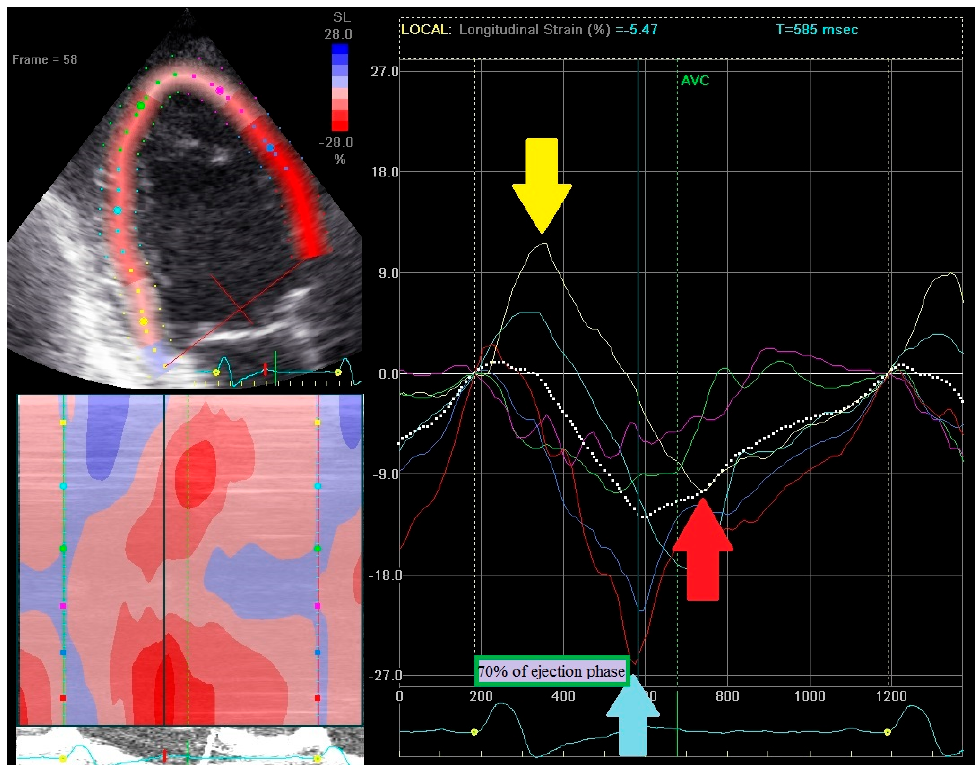
Figure 4. RSPI calculation: 3-chamber view. In 3-chamber view patient reached 3 points: early contraction of the basal segment (red line; light blue arrow) in the anteroseptal wall [1 point] but peak contraction exceeds 70% of the systolic ejection phase [0 point]; early prestretching of the basal segment (yellow line; yellow arrow) in the posterior wall [1 point] with the peak contraction (red arrow) after aortic valve closure [1 point].